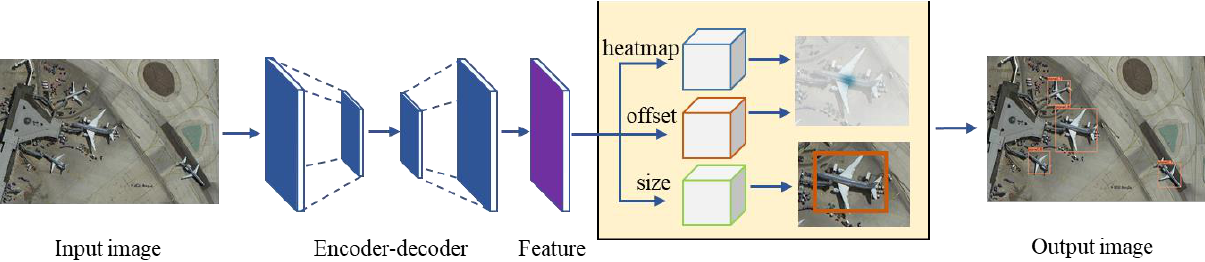
Figure 2. The framework of the dynamic adjustment network. Dynamic gradient adjustment (DGA) module dynamically refine the prediction of heatmap.